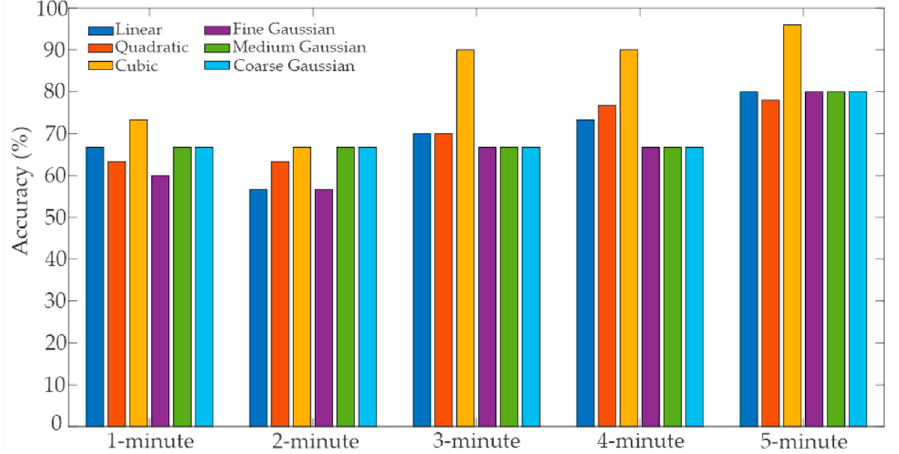
Figure 9. Accuracy for each window length for the SVM classifier.